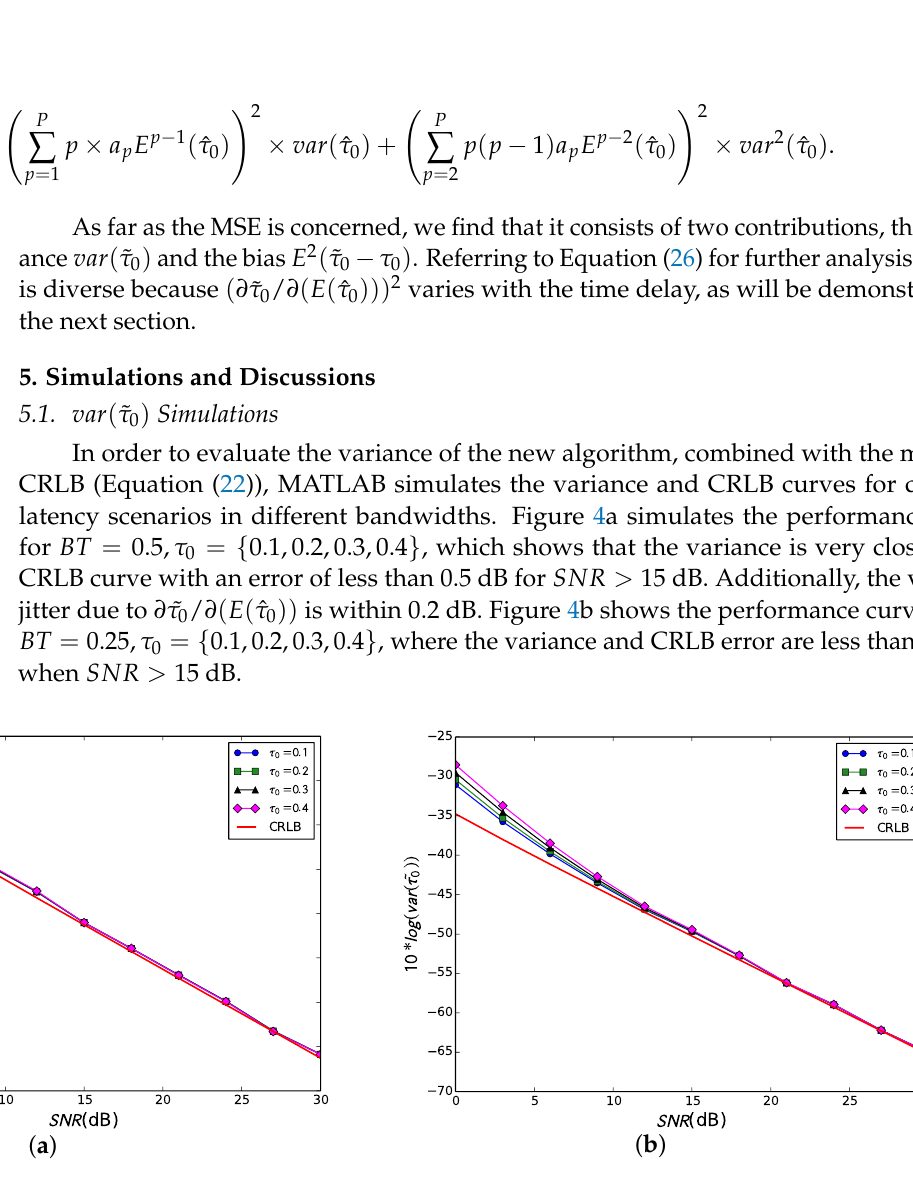
Figure 4. var ( ˜ τ 0 ) simulations with various bandwidths and time delays. ( a ) BT = 1/2, N = 16,384, P = 11, θ = 1; ( b ) BT = 1/4, N = 16,384, P = 11, θ =